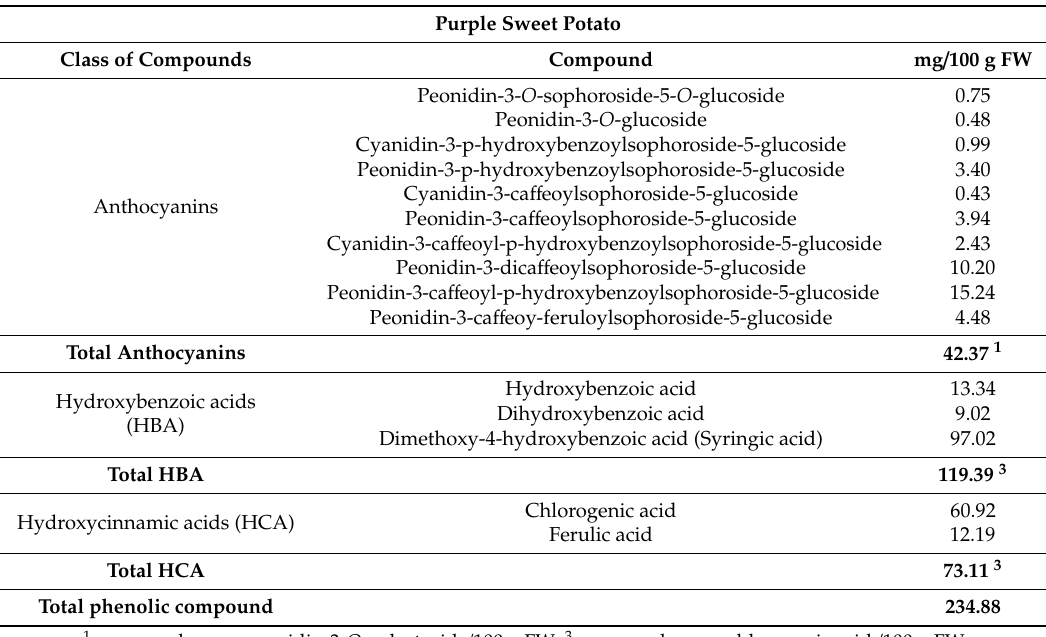
Table 11. Total polyphenolic compounds content in purple sweet